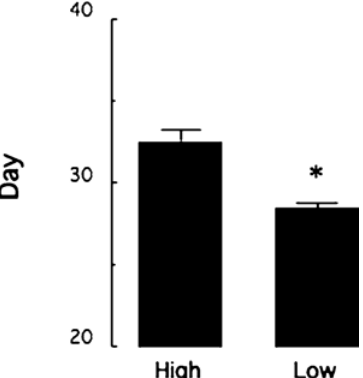
Figure 6. Onset of puberty. Mean 6 SEM day of vaginal opening in the female offspring of High (n=16) and Low (n=12) LG mothers revealing a maternal effect on the timing of pubertal development. * p ,